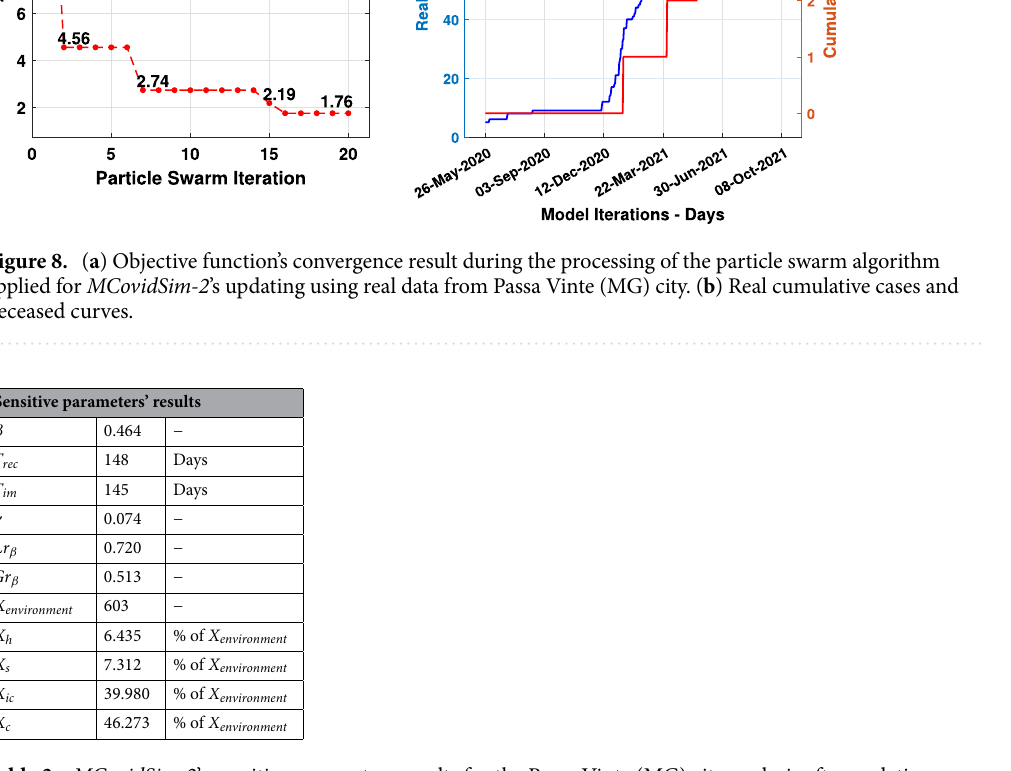
Table 3. MCovidSim-2 ’s sensitive parameters results for the Passa Vinte (MG) city analysis after updating process.